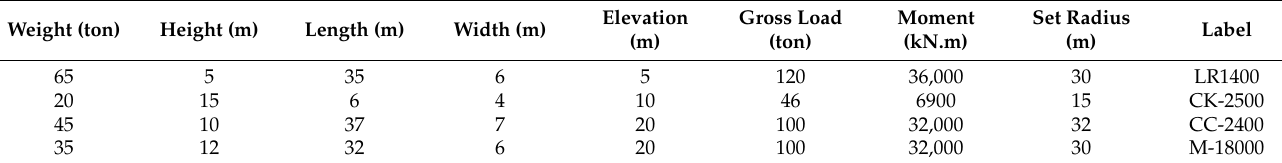
Table 1. Examples of the records in the